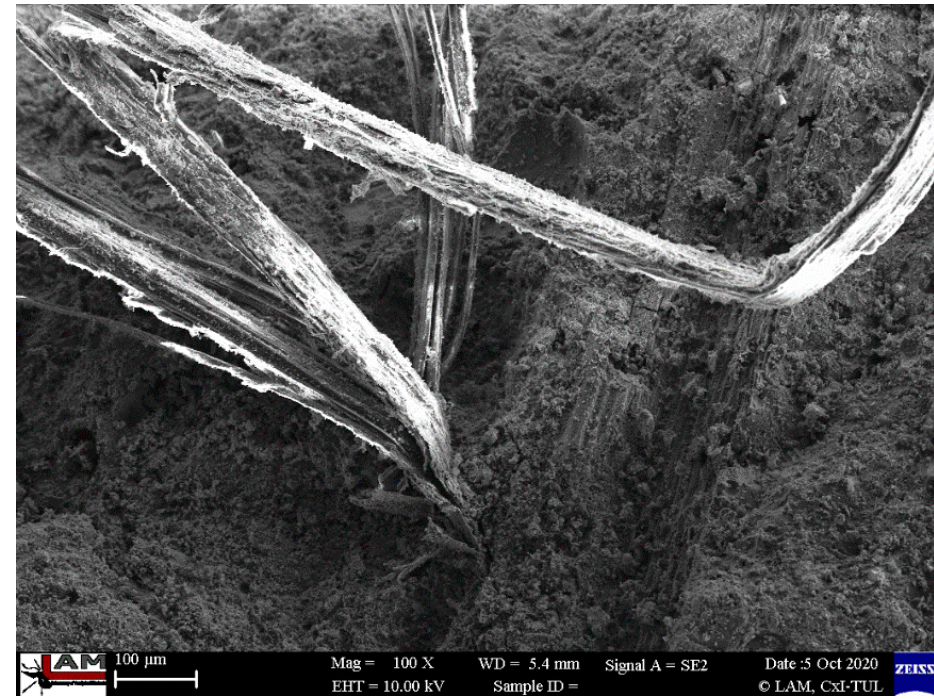
Figure 12. Microstructure of injected samples reinforced with flax fibers.